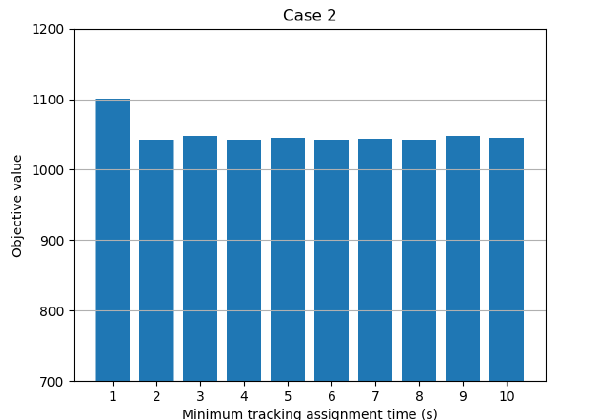
Figure 9. Objective value with respect to minimum tracking assignment time.